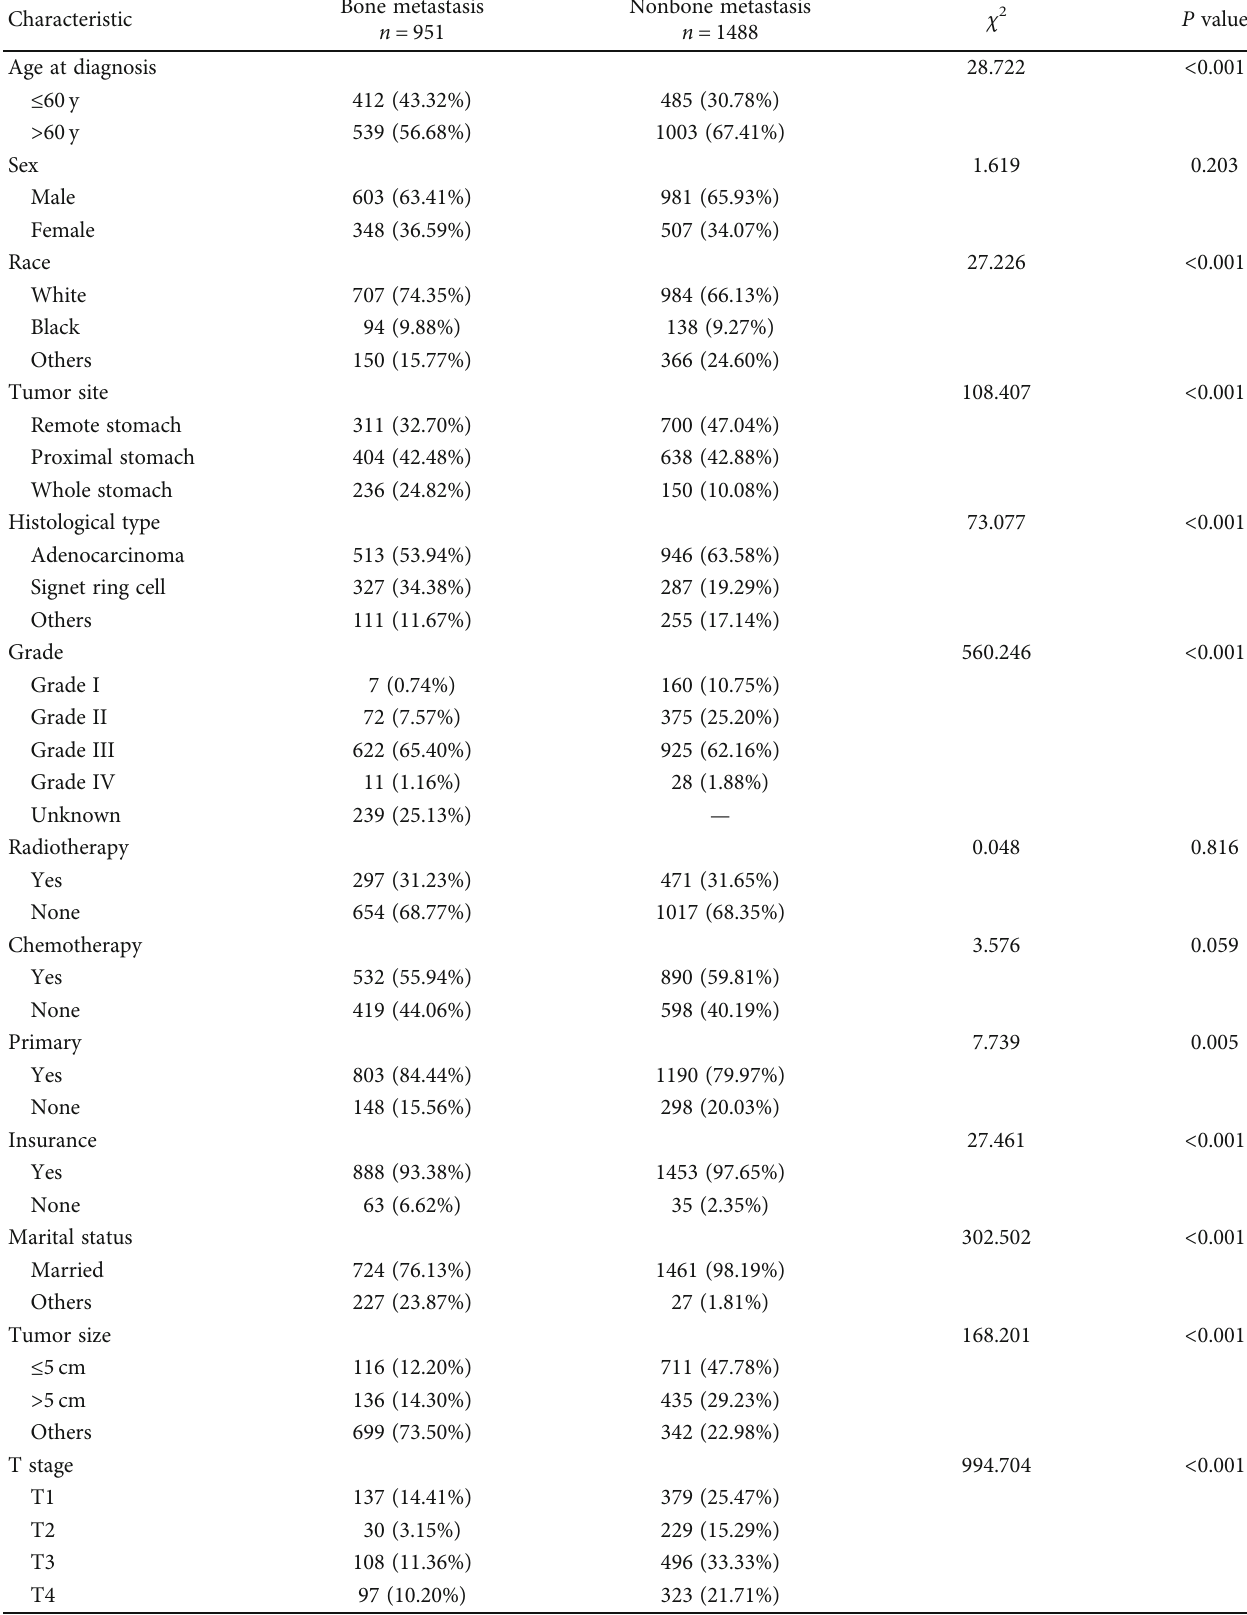
Table 1: Patient clinicopathological